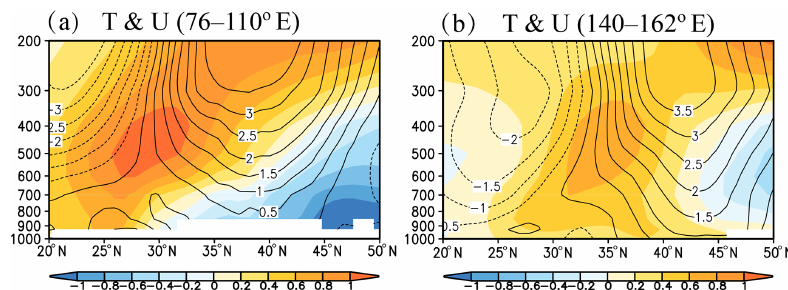
Figure 10. Height–latitude cross-section of the MAM composite difference between the strongest and weakest TPSH years (strongest– weakest) for the model in atmospheric temperature (shaded, ◦ C) and zonal winds (contoured, ms − 1 ) along (a) 76–110 ◦ E and (b) 140– 162 ◦ E.